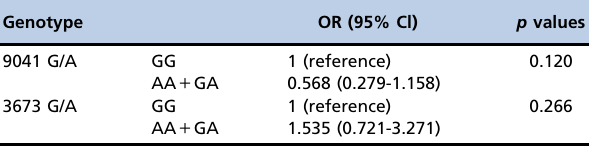
Table 3 - 9041 G/A and 3673 G/A in postmenopausal patients with osteoporosis with and without fracture.